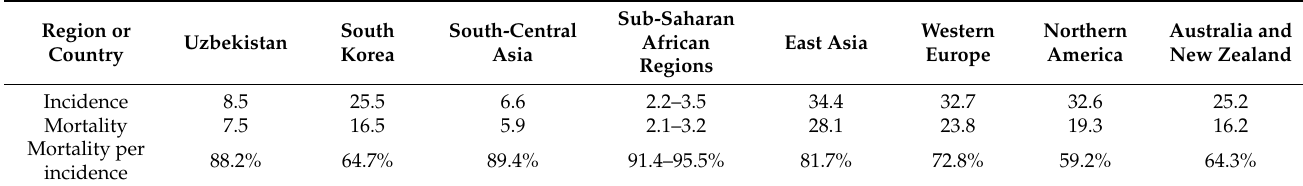
Table 1. Brief global statics of lung cancer, including Uzbekistan and South